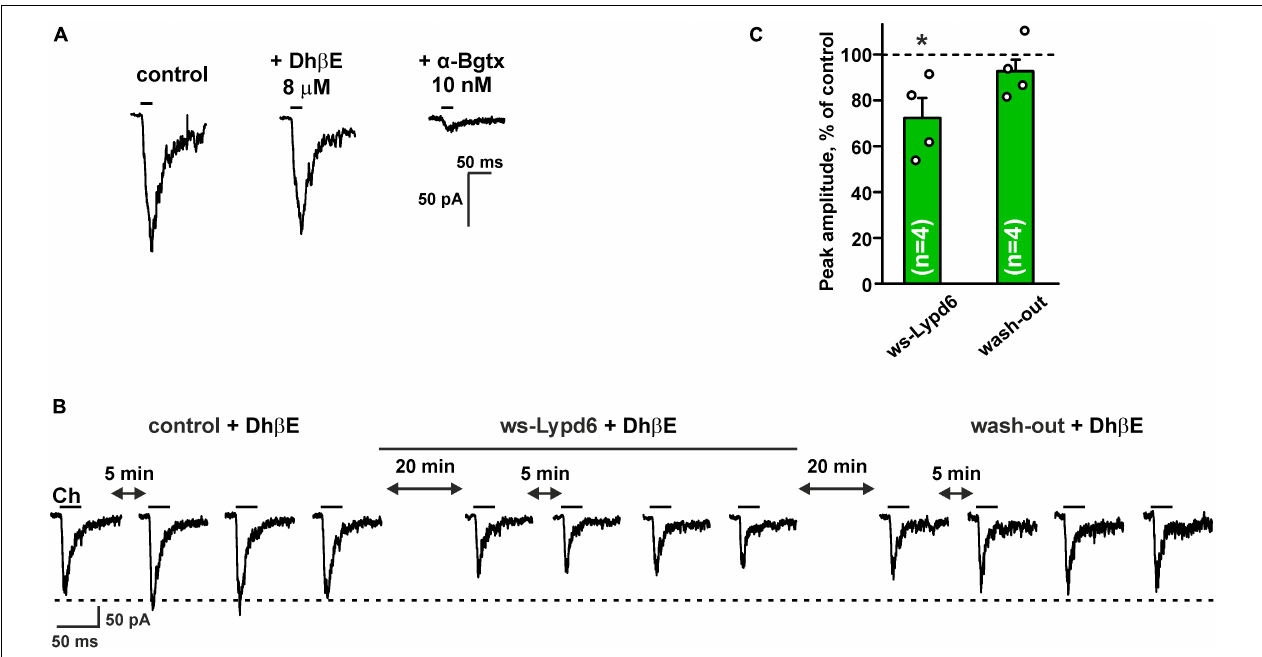
FIGURE 5 | Ws-Lypd6 inhibits choline-evoked currents at nAChRs in the hippocampus. (A) Representative responses to 1 mM choline pulses in the absence and presence of 8 µ M Dh β E or 10 nM α -Bgtx. (B) Representative responses to 25 ms pulses of 1 mM choline (Ch) recorded in one cell in the absence and presence of 1 µ M ws-Lypd6. (C) Peak amplitude of the choline-evoked currents in the presence of 1 µ M ws-Lypd6 and after wash-out recorded in four different cells taken from different animals ( n = 4 slices, four rats). Four responses (like shown in B ) were averaged for each slice and normalized to the average control amplitude (100%, shown by dotted line). The data are presented as mean ± SEM. * ( p < 0.05) indicates significant difference from the control value ( t -test). Experiments in (B,C) were performed in presence of 8 µ M Dh β